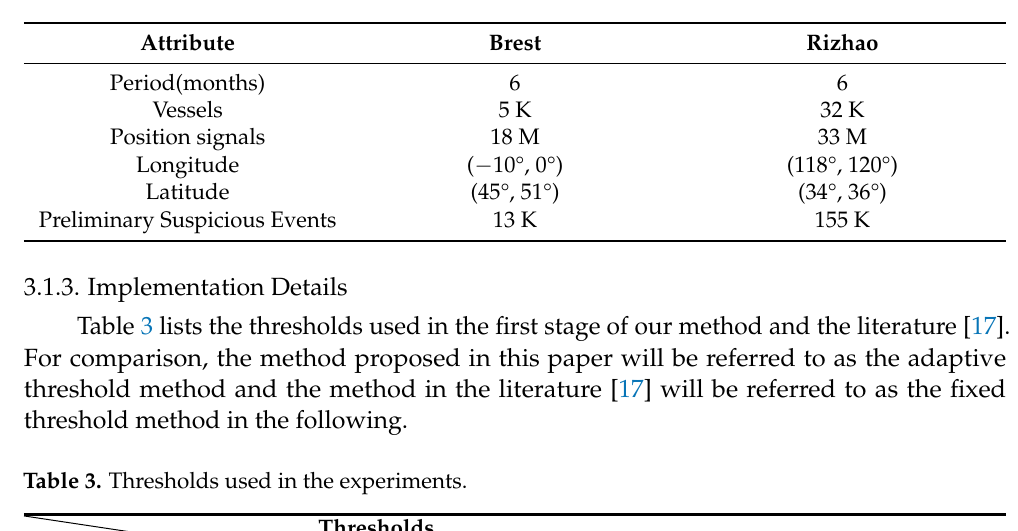
Table 2. Datasets’ characteristics.